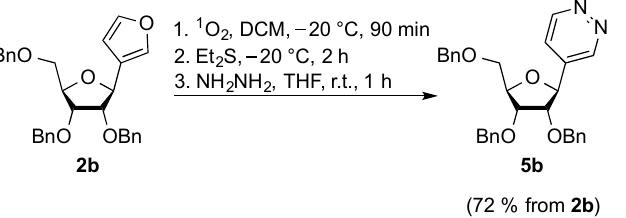
Scheme 4. One-pot synthesis of the 4-(2 (cid:48) ,3 (cid:48) ,5 (cid:48) -tri- O -benzyl- β - D -ribofuranosyl)pyridazine ( 5b ).